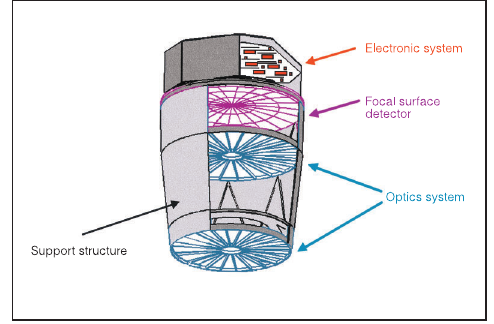
Fig. 8. View of the EUSO main